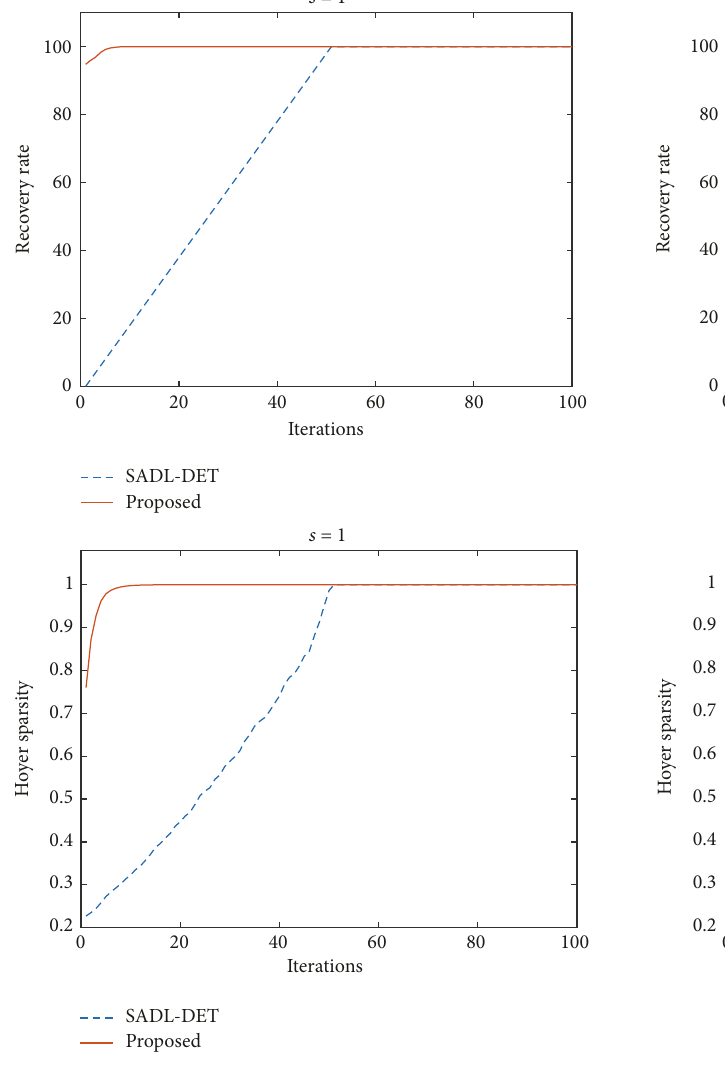
Figure 7: The comparison with SADL-DET when 𝑠 = 1 . Figure 8: The comparison with SADL-DET when